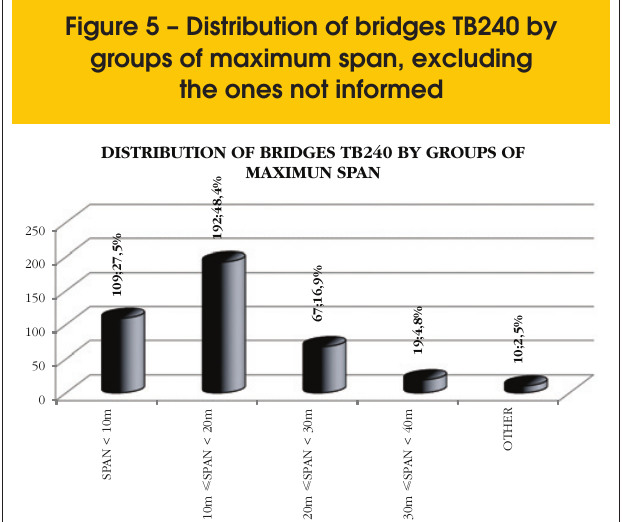
Figure 5 – Distribution of bridges TB240 by groups of maximum span, excluding